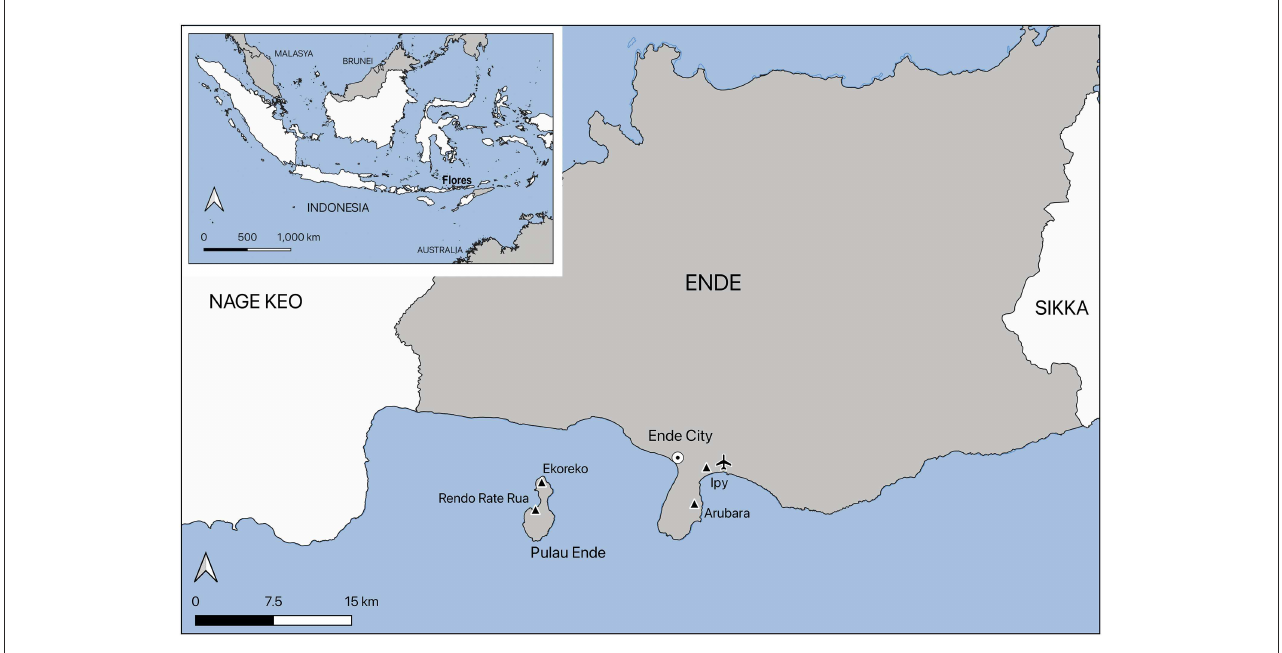
FIGURE1 Map of Ende Regency, Flores, Eastern